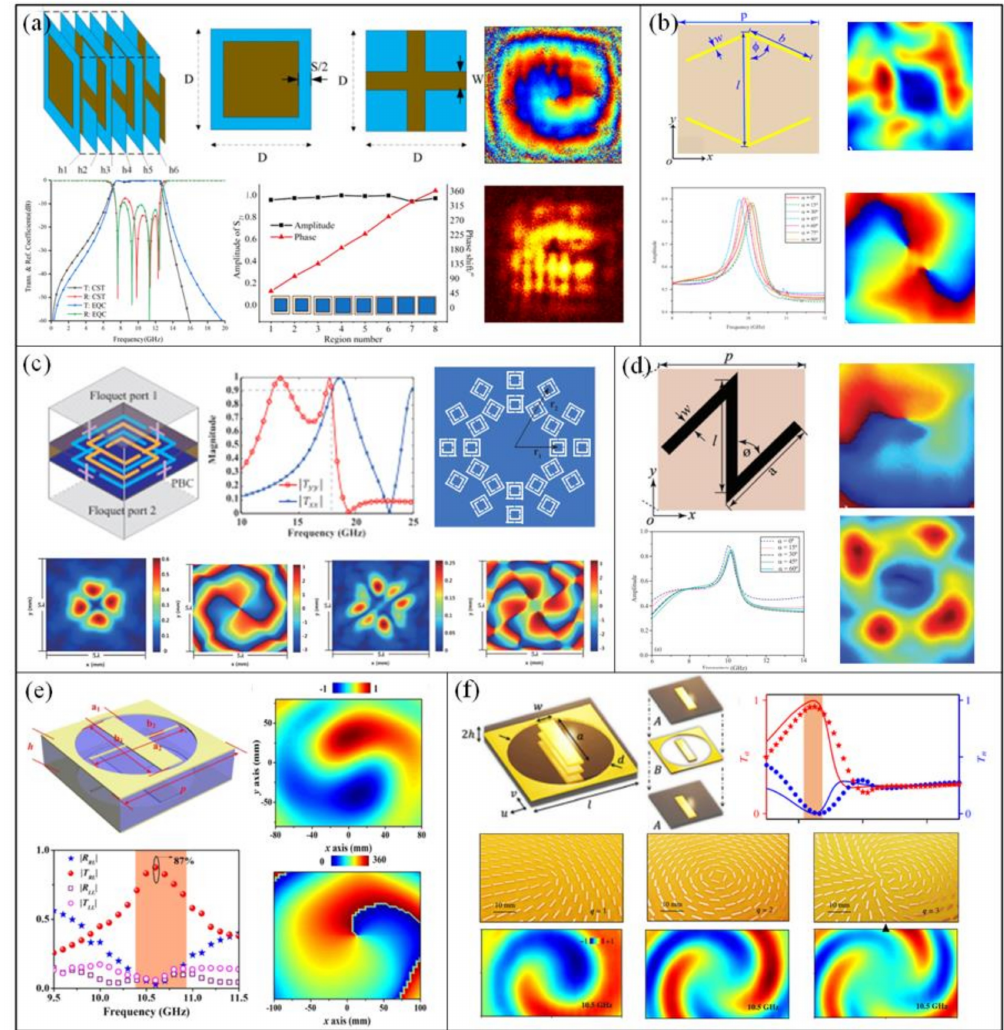
Figure 12. Transmissive OAM metasurfaces. ( a ) OAM metasurfaces based on MEFSS [72]. ( b ) OAM metasurfaces based on photon spin Hall e ff ect (PSHE) unit of two double-headed arrows [73]. ( c ) OAM metasurfaces based on complementary split ring resonators [74]. ( d ) OAM metasurfaces based on PSHE unit of Z-shaped cell [75]. ( e ) OAM metasurfaces based on cross bar and holey metallic ring resonator [76]. ( f ) OAM metasurfaces based on ABA structure